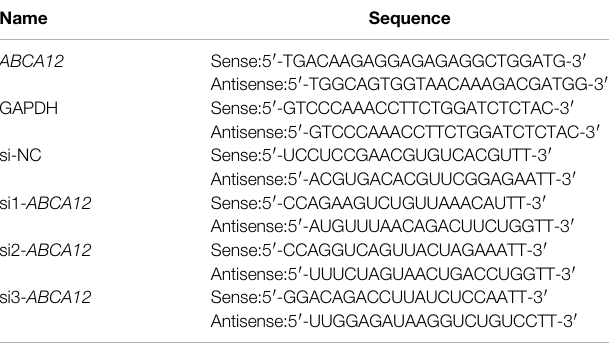
TABLE 1 | Primer sequences of ABCA12 and siRNAs. Name